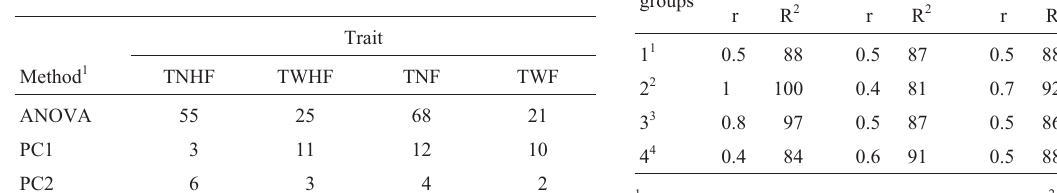
Table 2 - Number of trait measurements for the total number of healthy fruit per plant (TNHF), total weight of healthy fruit per plant (TWHF), total number of fruit (TNF) and total weight of fruit (TWF) obtained from data for 34 tomato genotypes (32 accessions and 2 control genotypes) associated to the degree of determination of the genotypic value (R 2 ) of 85%.